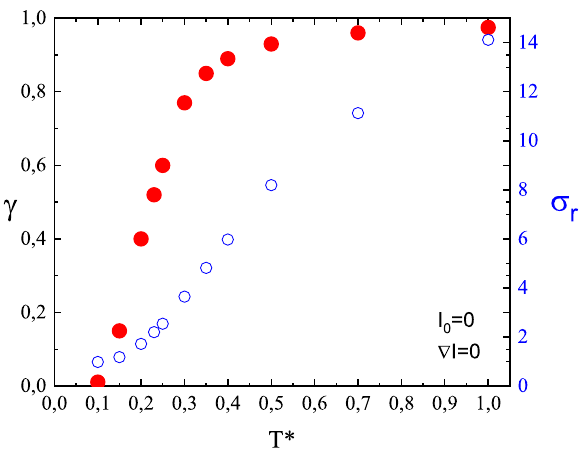
Figure 6. Temperature dependence of exponent γ (red full circles, left axis) and standard deviation σ r of displacement of CM of chains (white circles, right axis) for a system of single chains in the absence of